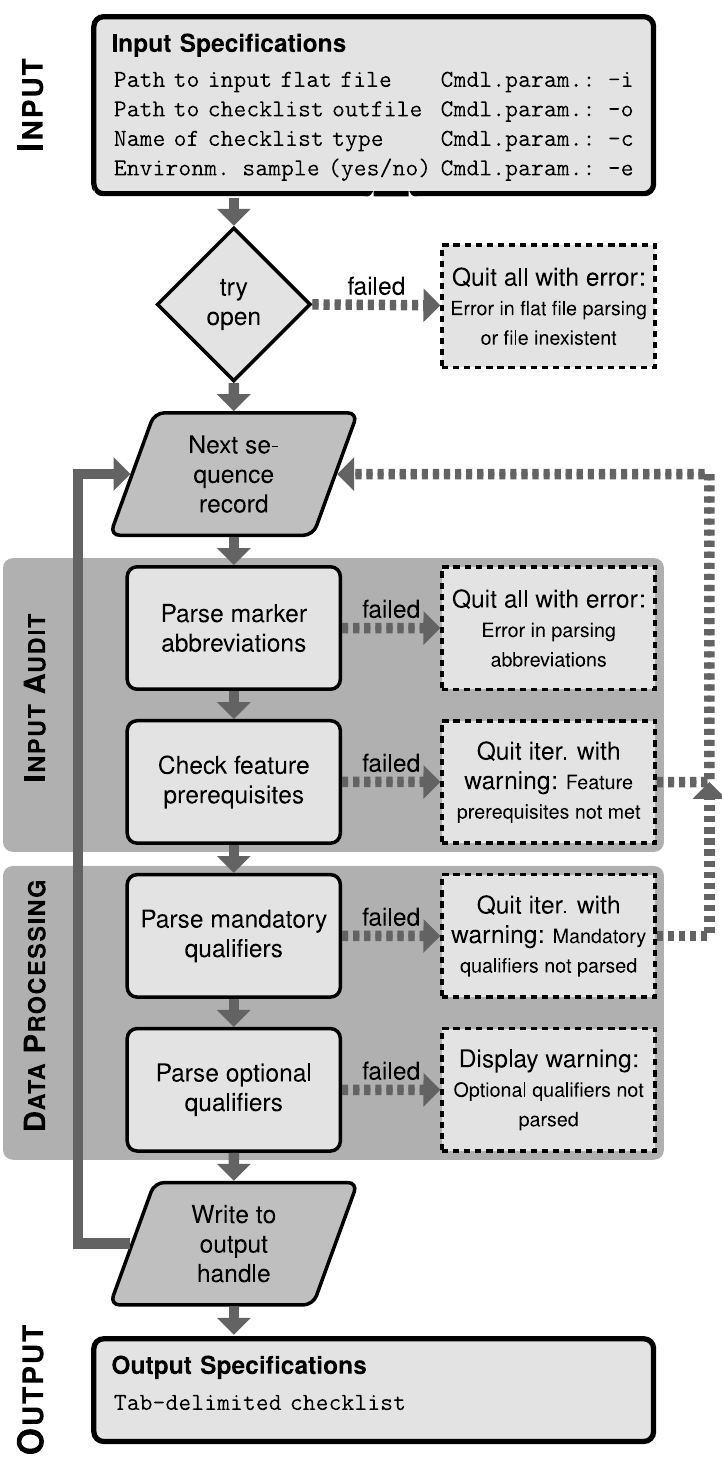
Fig 3. Overview of the internal structure of EMBL2checklists. The overview illustrates the two main processes that are executed sequentially for each sequence record: input audit and data processing. Rhomboid fields indicate the start and end points of the loop across sequence records. Fields with dotted outlines indicate states where standard data processing failed, which results either in aborting the current iteration (arrow back to next sequence record) or the software run as a whole. Abbreviations used: cmdl.param. = command-line parameter; iter. = iteration.